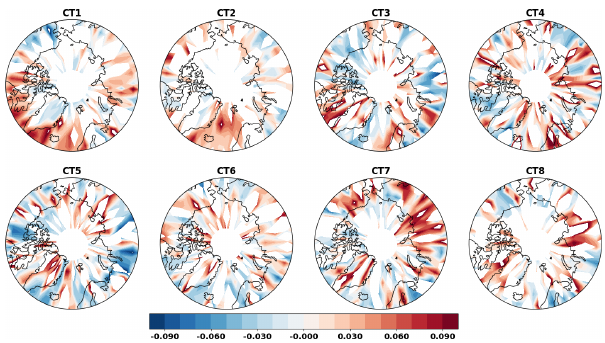
Figure 7. Tropospheric AOD anomalies based on CALIOP- CALIPSO data for the eight circulation types with 90%